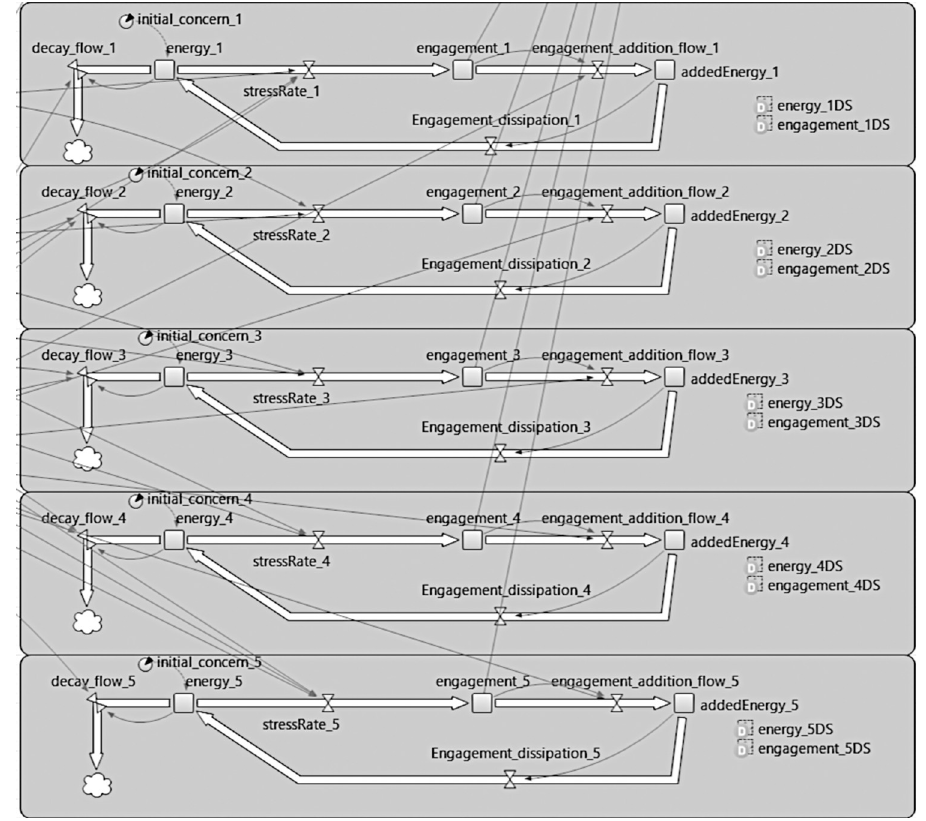
Fig 15. A visual depiction of the system dynamics model used to model threat increases and decreases as functions of stimulus and habituation.